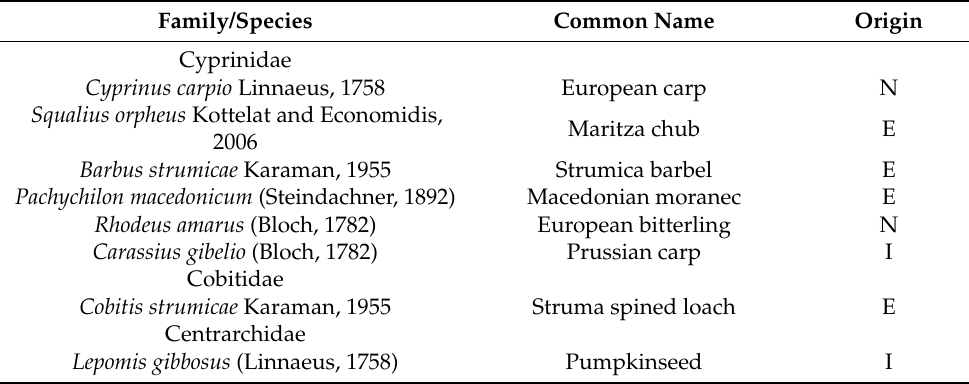
Table 3. Fish species suffered deaths at Bogdanas River, in June